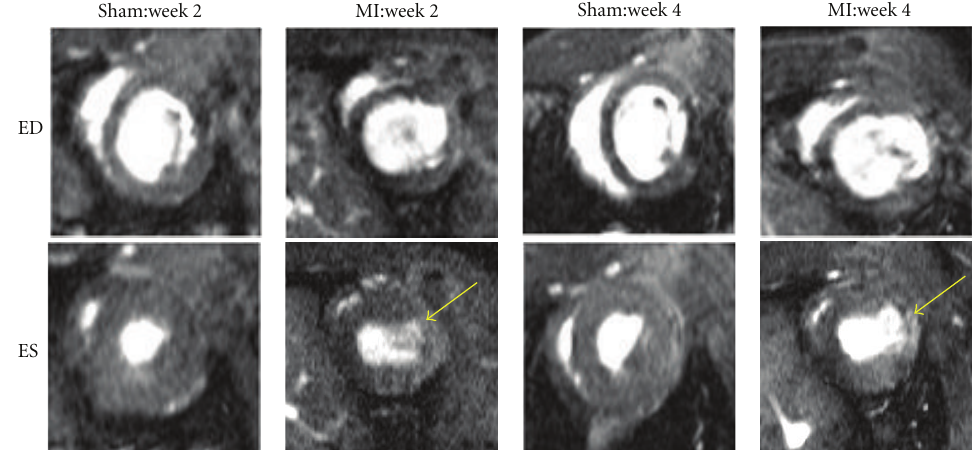
Figure 3: Short-axis images of the heart for sham and MI rats. Top row shows ED images 2 and 4 weeks after surgery, and bottom row shows the same for ES. ES images demonstrate significant dilation and wall thinning (arrows) in MI group at 2 and 4 weeks after surgery.